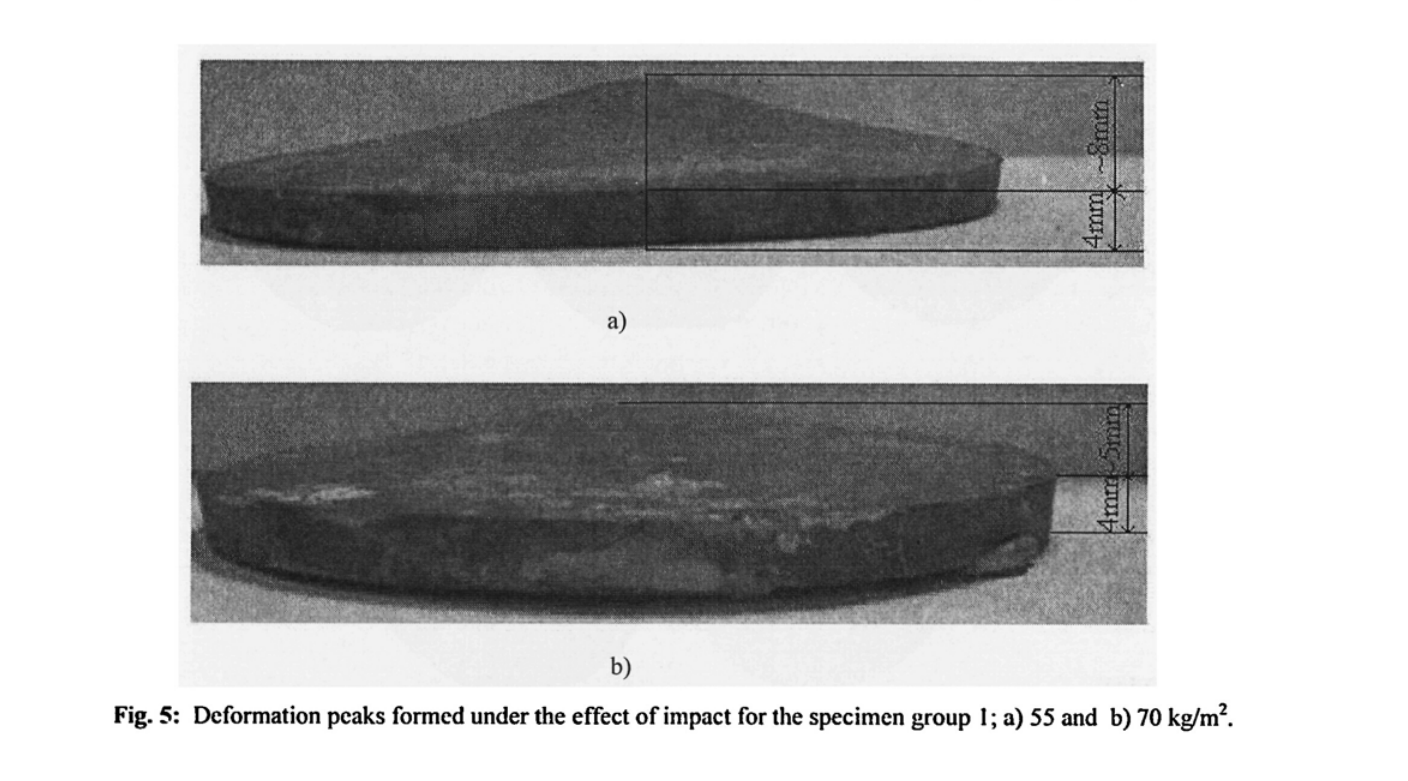
Fig. 5: Deformation peaks formed under the effect of impact for the specimen group 1; a) 55 and b) 70 kg/m 2